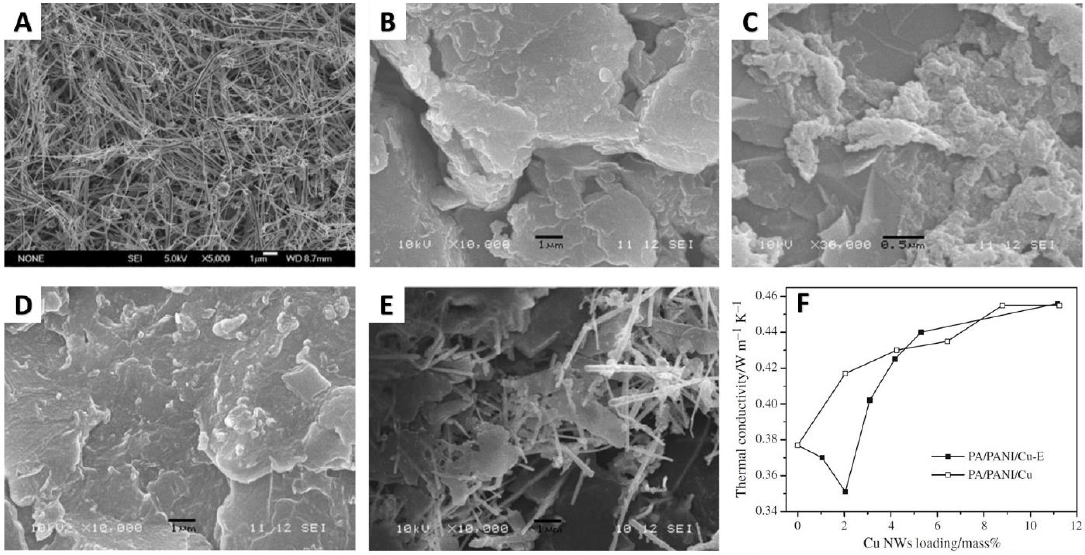
Figure 12. SEM images of ( A ) CuNWs, ( B ) palmitic acid (PA)/polyaniline (PANI)-2, and ( C ) PA/PANI-2 was washed with ethanol three times. ( D ) PA/PANI/Cu-E-6 and ( E ) PA/PANI/Cu-5 ( F ) thermal conductivity of the form-stable PCMs doped with CuNWs [77].